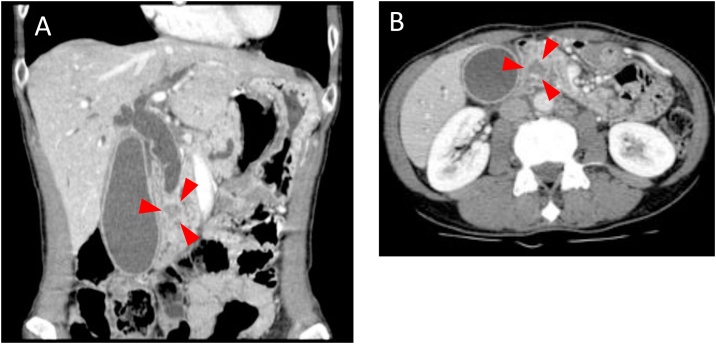
Computed tomography (CT) scan showing pancreatic head tumor (red arrow heads) causing dilatation of biliary and pancreatic ducts. A: axial view; B: coronal view.